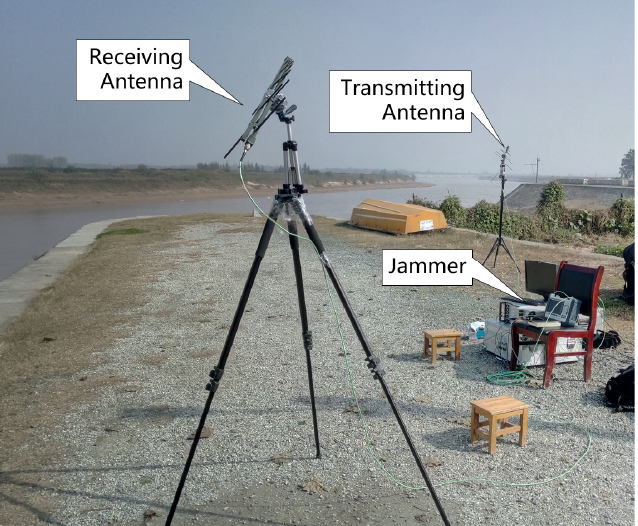
Figure 13. The jammer, the transmitting antenna, and the receiving antenna.